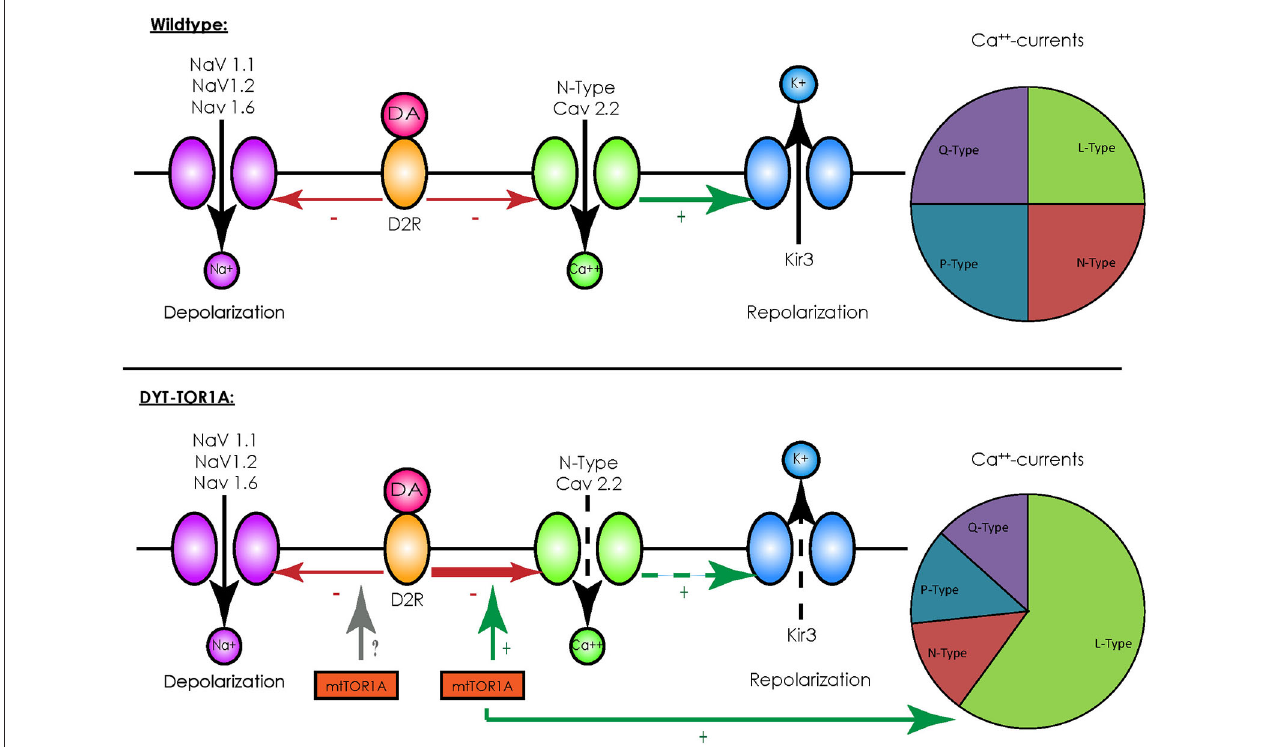
results in a reduction of spiking and the spontaneous firing rate. In the presence of mutated TorsinA (mtTor1A) (lower panel), the inhibitory coupling of D2R to CaV 2.2 is enhanced and the amount of currents through the N-type channels in proportion to the total cellular calcium currents is increased (represented by the changes in the pie charts). This shifts the net effect of D2R towards enhanced activity of cholinergic interneurons. Whether mutant TorsinA also affects the coupling of D2R to NaVs is currently unknown.